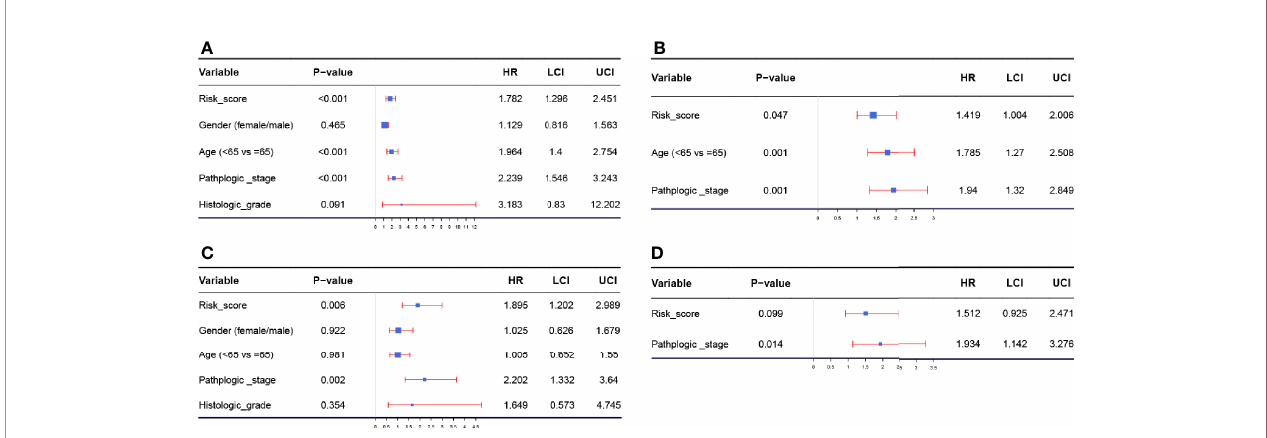
FIGURE 4 | (A) Forest plot summary of analyses of OS univariate analysis of Risk score, gender, age, pathologic stage, and histologic grade by using TCGA-BLCA data. (B) Forest plot summary of analyses of OS multivariate analysis of Risk score, age, and pathologic stage by using TCGA-BLCA data. (C) Forest plot summary of analyses of DFS univariate analysis of Risk score, gender, age, pathologic stage, and histologic grade by using TCGA-BLCA data. (D) Forest plot summary of analyses of DFS multivariate analysis of Risk score, age, and pathologic stage by using TCGA-BLCA